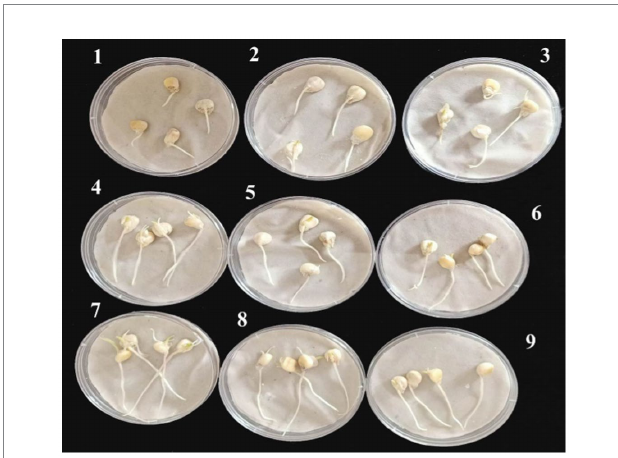
FIGURE 7 Representative maize seeds at 4 days of germination after their treatment with the six tested nanoemulsions in compared to controls: (1) infected seeds without treatment (+ control), (2) uninfected seeds without treatment ( − control), (3) infected seeds with the chemical fungicide, and (4–9) infected seeds treated with (0_T80, 5_T80, 10_